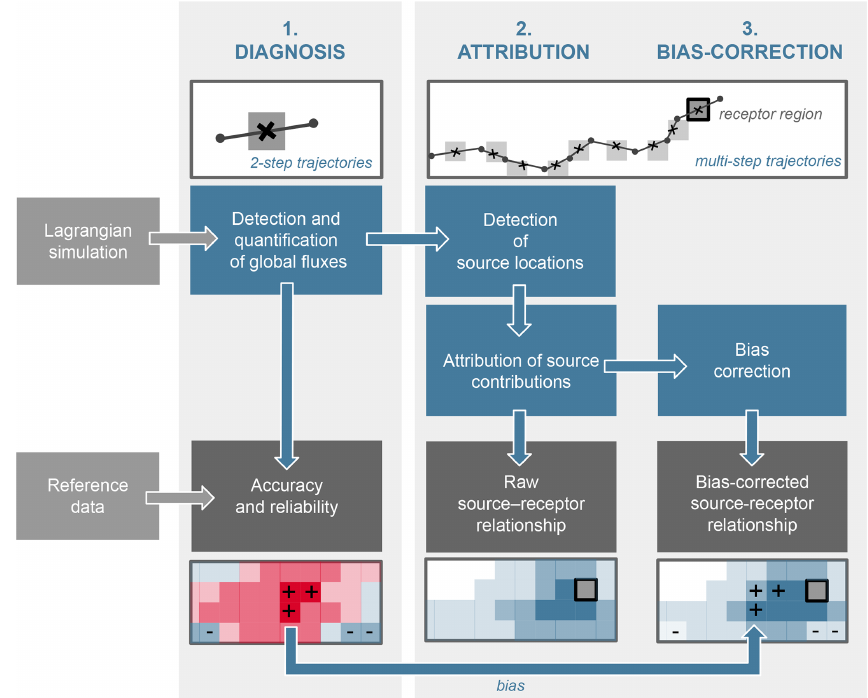
Figure 1. Workflow for the process-based evaluation of Lagrangian trajectories to establish source–receptor relationships. In a first step, the output from a Lagrangian model is used to diagnose processes and quantify fluxes, which enables a validation of the accuracy and reliability of the methodology. In a second step, the fluxes along with individual (backward or forward) trajectories are evaluated and source contributions are evaluated and/or adjusted to enable a mass- and energy-conserving attribution of sources. This step also entails the attribution of sources to a receptor or sink quantity, which is further aggregated to predefined space scales and timescales (e.g., daily values on a grid) and yields a first estimate of the quantitative source–receptor relationship. In a third step, these estimates are bias-corrected using data from the first step, and the resulting dataset is used for analysis. The images at the bottom show the bias of the Lagrangian simulation (with red indicating an overestimation of the local flux and blue indicating an underestimation of the local flux) as estimated in the diagnosis step (left), the biased source regions as estimated in the attribution step (middle; the grey cell indicates the receptor region), and the bias-corrected source regions after the bias correction step (right). The color intensity indicates the magnitude of the bias and the source region contribution. Note that + ( − ) signs indicate substantially lower (higher) values in the Lagrangian simulation for easier reference across all